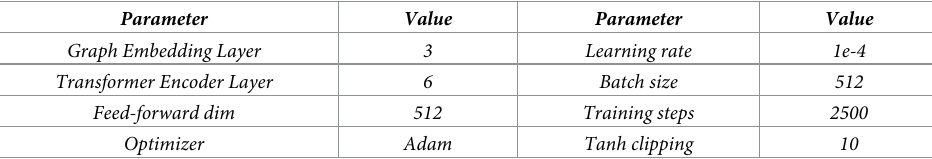
Table 1. Hyperparameters used for